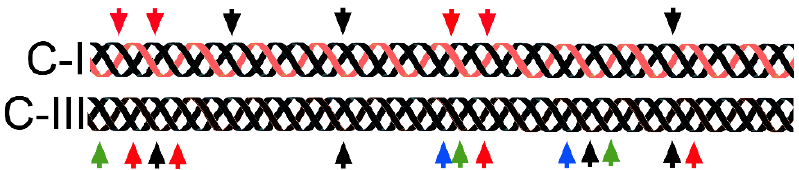
Figure 2. Sites of binding of collagen-specific receptors in collagen I (C-I) and collagen III (C-III). Red arrows; integrin-binding sites, black arrows; discoidin domain receptor (DDR)-binding sites, green arrows; glycoprotein VI (GPVI)-binding sites, blue arrows; leukocyte-associated immunoglobulin-like receptor 1 (LAIR1)-binding sites.